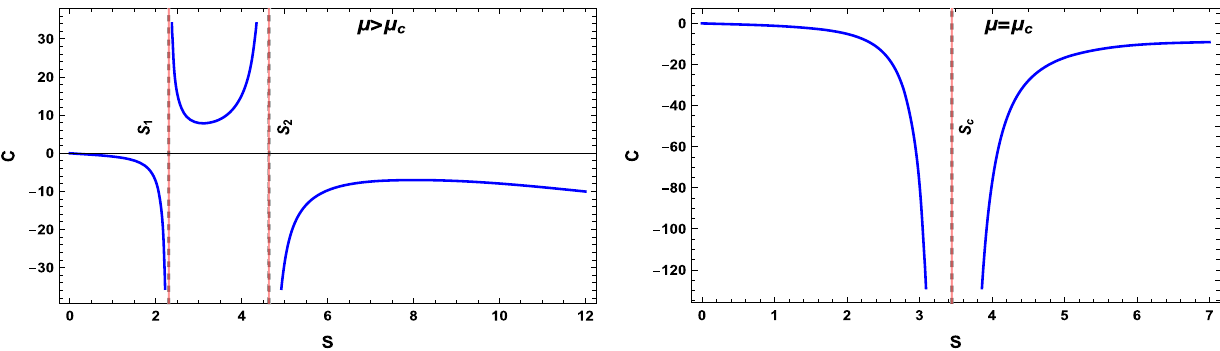
Fig. 3 Grand canonical ensemble: temperature as a function of S (left). The Gibbs free energy versus T for the neutral BH (right). The following values have been used for c = 1 , α = 1 and β = 2